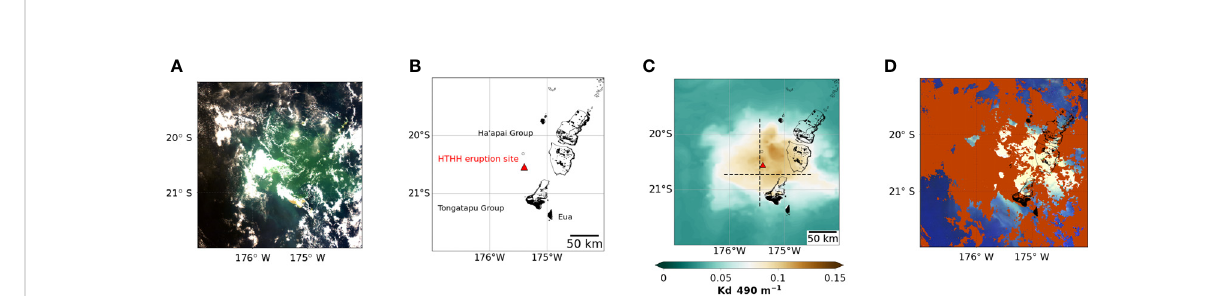
FIGURE 1 (A) True Color MODIS image showing the Tongan islands surrounded by discolored waters on 17 January 2022. (B) Map of Tongatapu island and other island groups in Tonga indicating the eruption site of HTHH (in red). (C) Interpolated CMEMS K d concentration on 17 January 2022 with a coral reef shape fi le overlay published by the Tongan Department of Environment (outlined in black around land masses). The dashed black lines across the patch depict the analyzed line transects along latitude of 20.73°S and longitude of 175.45°W. (D) RGB L2 composite image of Rrs at 443, 555 and 678 nm. Cloud cover is masked in